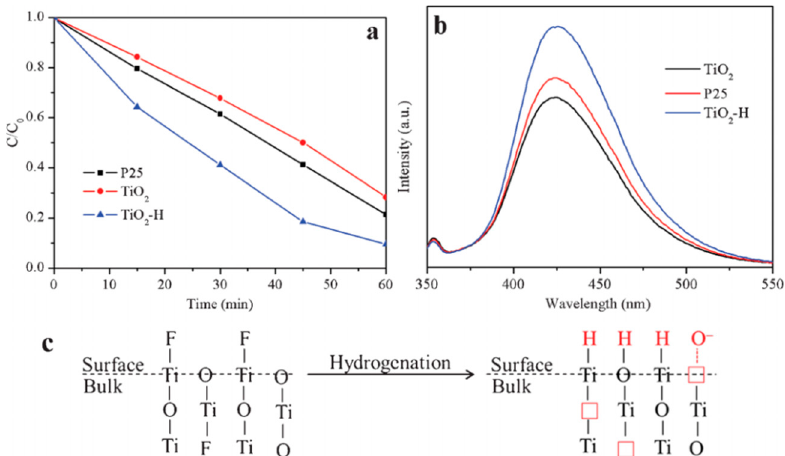
Figure 21. Photocatalytic decomposition of MB ( a ) and • OH generation measurement ( b ) of TiO 2 and